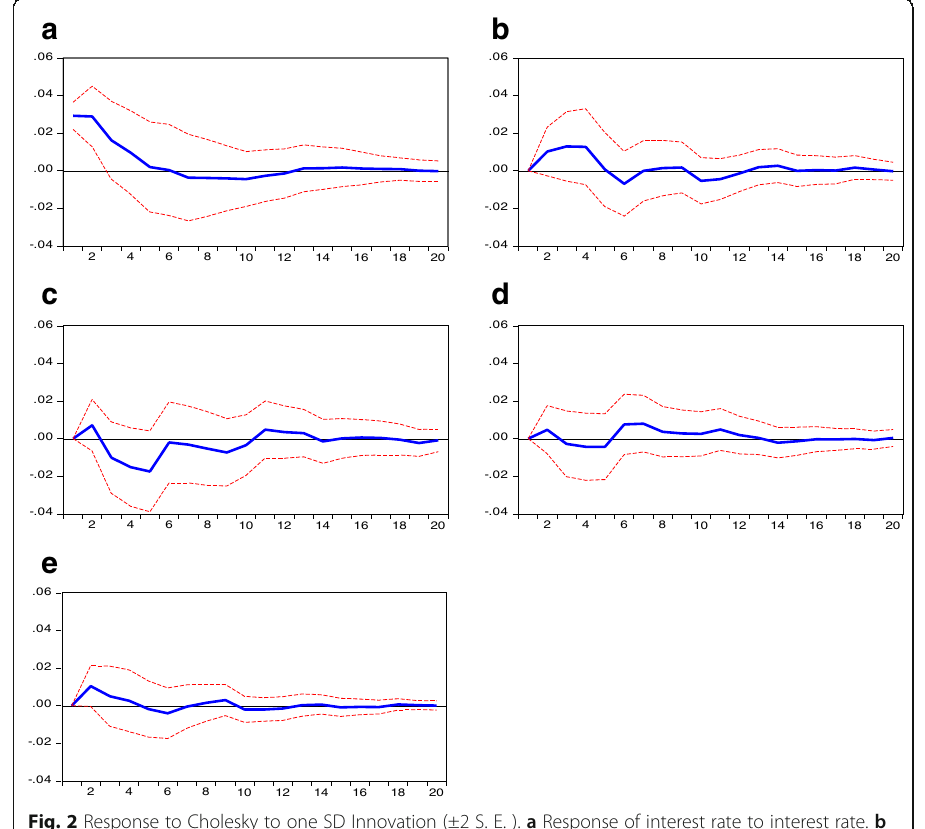
Fig. 2 Response to Cholesky to one SD Innovation (±2 S. E. ). a Response of interest rate to interest rate. b Response of interest to M1 money growth. c Response of interest rate to income growth. c Response of interest rate to exchange rate change. d Response of interest rate to budget deficit. Source: author ’ s